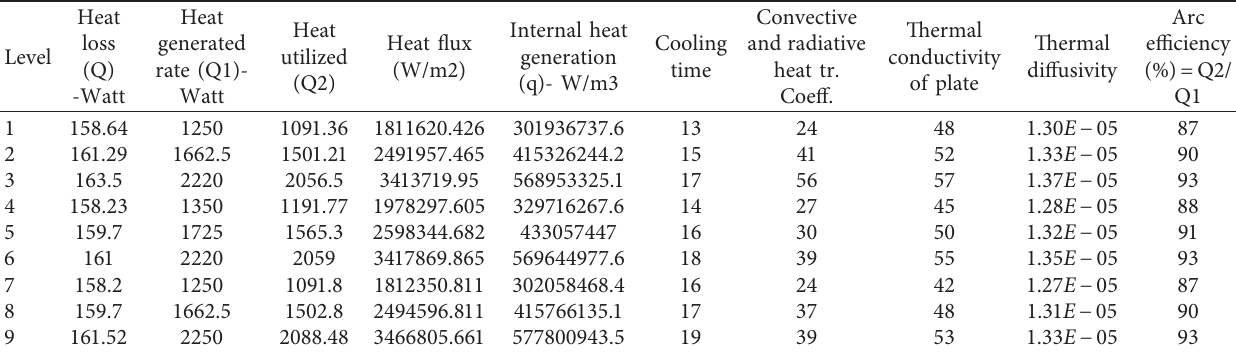
Table 5: Thermal results of double V 45 ° .